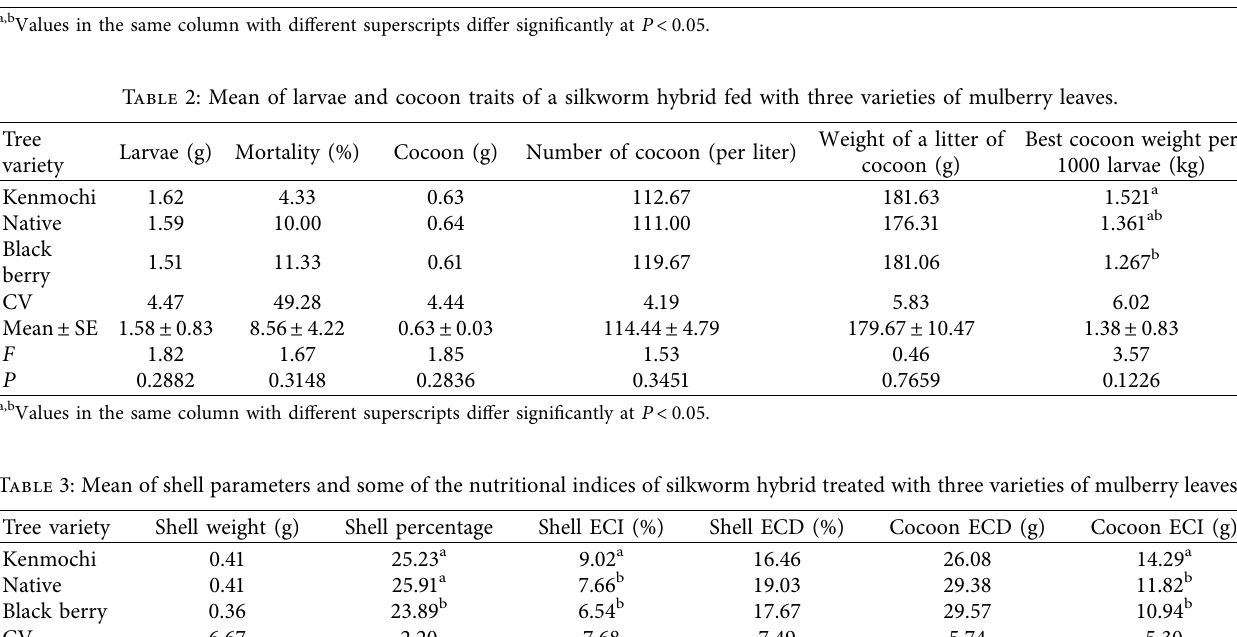
Table 1: Mean of leaf ingesta and digesta parameters of silkworm hybrid treated with three varieties of mulberry leaves. Tree variety Native Mean ± SE